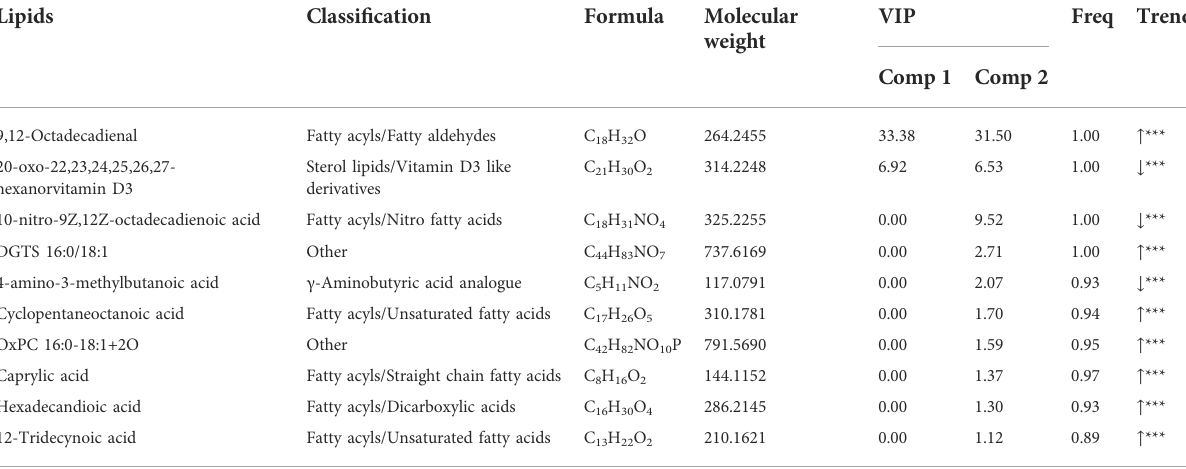
TABLE 2 Identi fi ed differential lipids for classifying psychiatric patients and healthy controls.